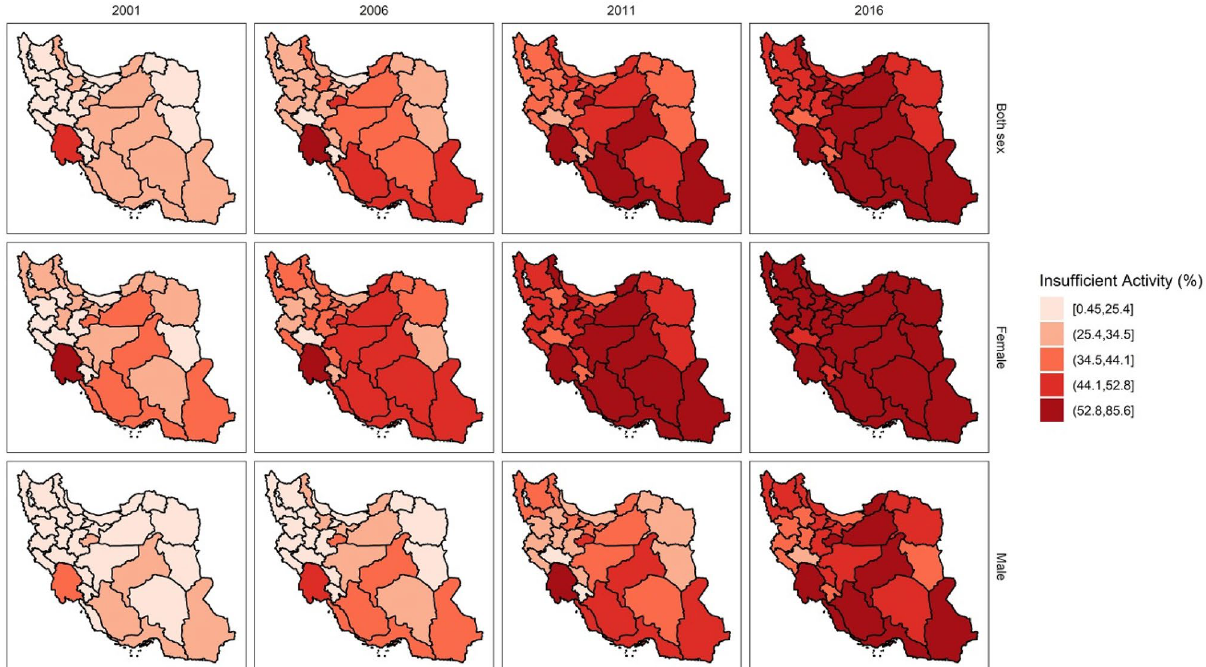
Figure 3. The subnational geographical distributon of IPA prevalence is demonstrated in four time points (2001, 2006, 2011, 2016) for male, female, and both genders. IPA: insufficient physical